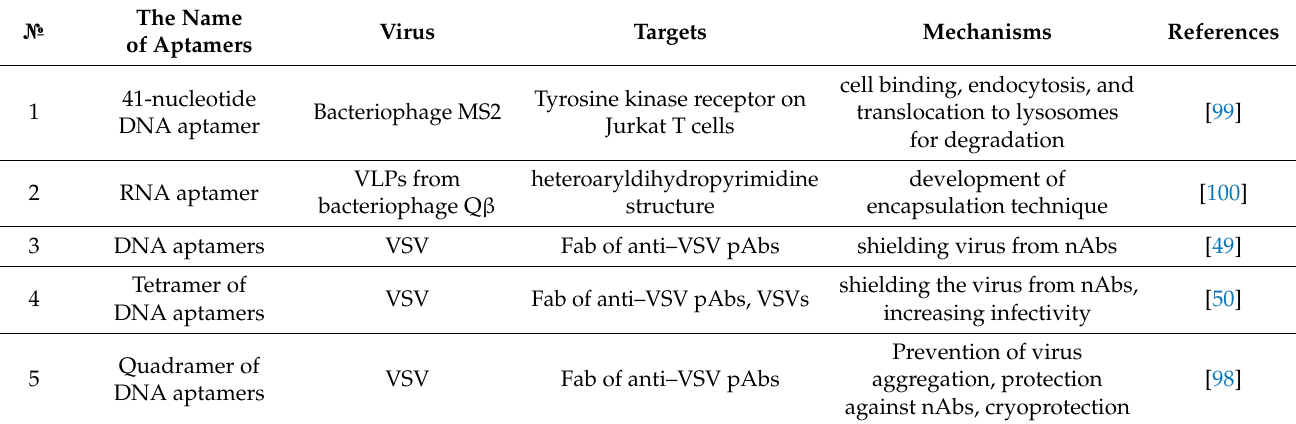
Table 1. Aptamers increased the antitumor efficacy of the oncolytic